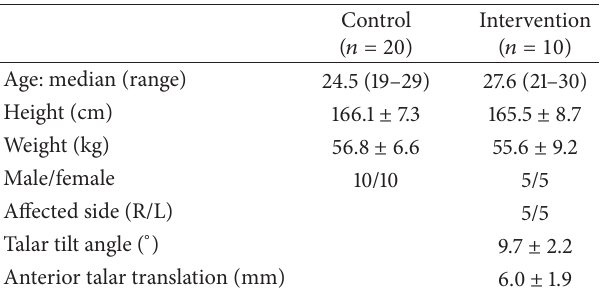
Table 1: Patient clinical data.